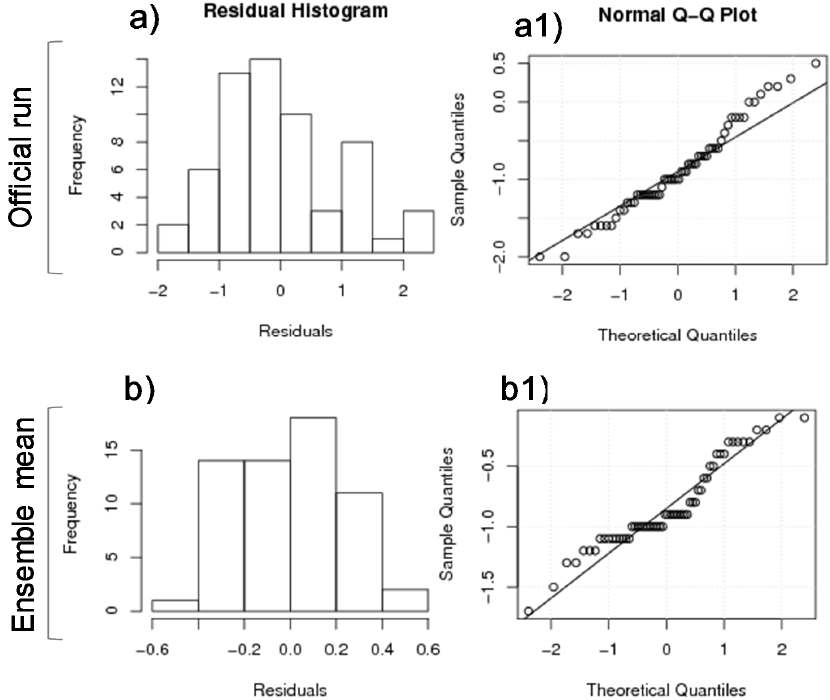
Figure 5. ( a , a 1 ) Residual histogram and normal Q-Q plot between PDSI forecasted and observed in validation period for the official run; ( b , b 1 ) Residual histogram and normal Q-Q plot between PDSI forecasted and observed in validation period for the ensemble mean.